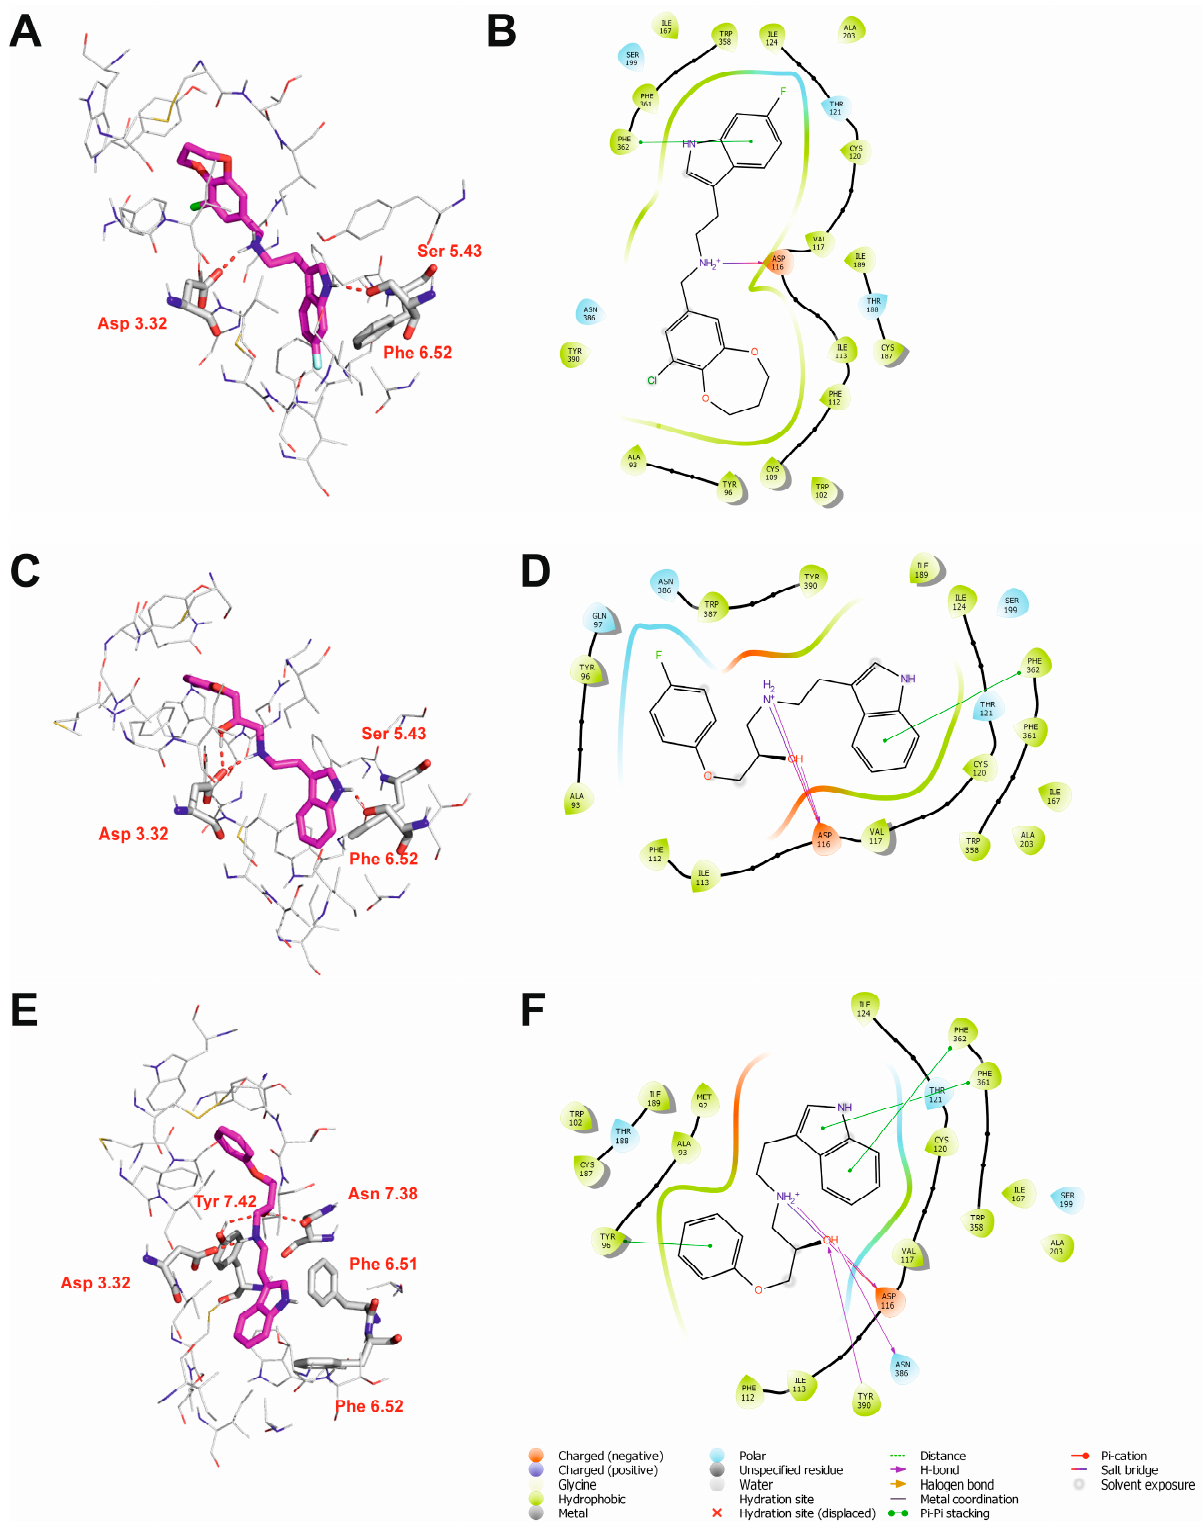
Figure 4. Molecular interactions of D2AAK5 ( A , B ), D2AAK6 ( C , D ), and D2AAK7 ( E , F ) with 5-HT 1A receptor based on molecular docking. ( A , C , E )—3D details of the binding site. Most important protein residues are shown as sticks with grey carbon atoms. Ligands are shown as sticks with magenta carbon atoms. Non-polar hydrogen atoms were omitted for clarity. Polar interactions are shown as red dashed lines. ( B , D , F )—2D overview of the binding